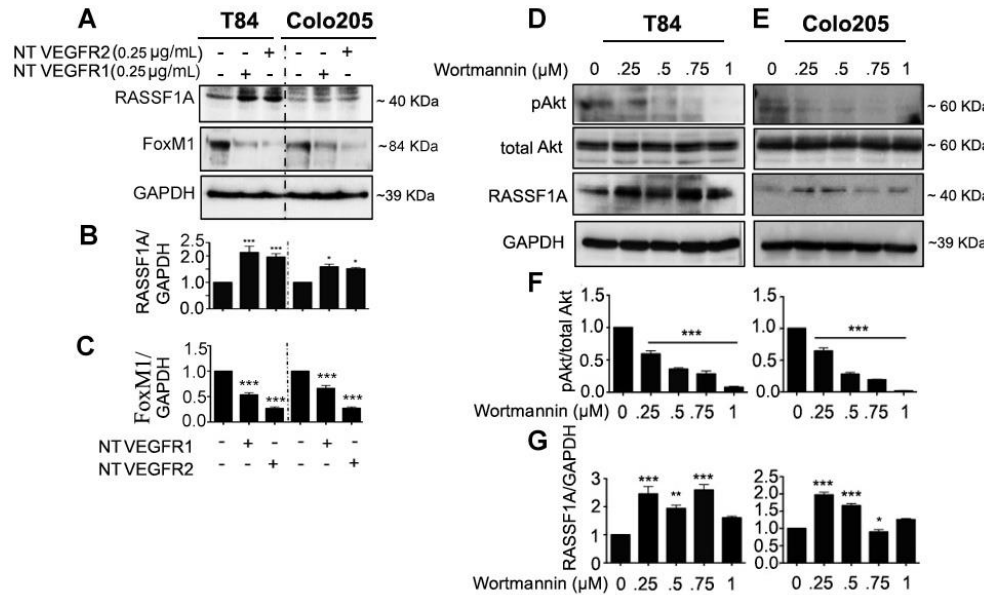
Figure 4. Neutralizing VEGF receptor antibodies and Akt inhibition upregulates RASSF1A and downregulates FoxM1 in mCRC. T84 and Colo 205 cells were treated with VEGF receptor 1 and VEGFR2 as indicated before (see Section 2.3). Protein expression from cell lysates was determined by immunoblotting for RASSF1A (( A ), upper panel) and FoxM1 (( A ), middle panel). Densitometry analysis was performed and normalyzed with GAPDH expression to demonstrate significant upregulation for RASSF1A ( B ) and downregulation of FoxM1 in the presence of neutralized (NT) VEGFR1 or VEGFR2 ( C ). ( D , E ) T84 and Colo 205 cells were treated with Akt inhibitor (wortmannin) with different doses (0–1 µ M) for 24 h. Cell lysates were analyzed for pAkt (1st lane), total Akt (2nd lane), RASSF1A (3rd lane) expression by immunoblot analysis and quantified by densitometry ( F , G ). The results are from three independent experiments. (* p < 0.05, ** p < 0.01, *** p <